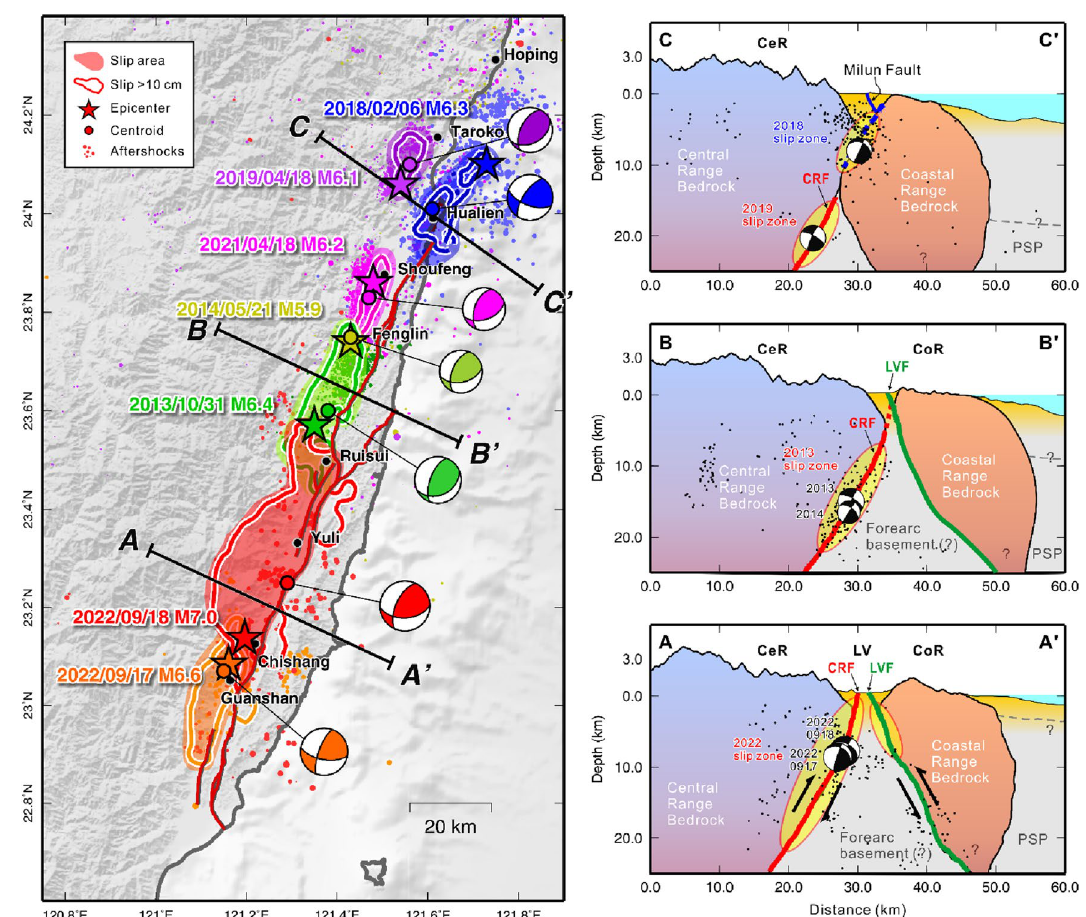
Figure 6. Big earthquakes occurred in eastern Taiwan along the LV from 2013 to 2022 (see also Table 1). The epicenters (stars) are given by the CWB earthquake report; the focal mechanisms and centroid locations of each event are taken from the RMT centroid reports 8 (https:// rmt. earth. sinica. edu. tw). The color contours indicate the slip areas of the large events based on the finite-fault source inversion studies 23–25 . The conceptual tectonic models for the CRF along the three profiles across the Longitudinal Valley suture from north to south are shown in the right panels. The red line indicates the west-dipping CRF, and the green line shows the east-dipping LVF. The dotted blue line indicates a shallow west-dipping fault plane where the rupture of the 2018 Hualien earthquake originated 23 . The map was generated by the GMT v.4.3.1 (https:// www. gener ic- mappi ng- tools.